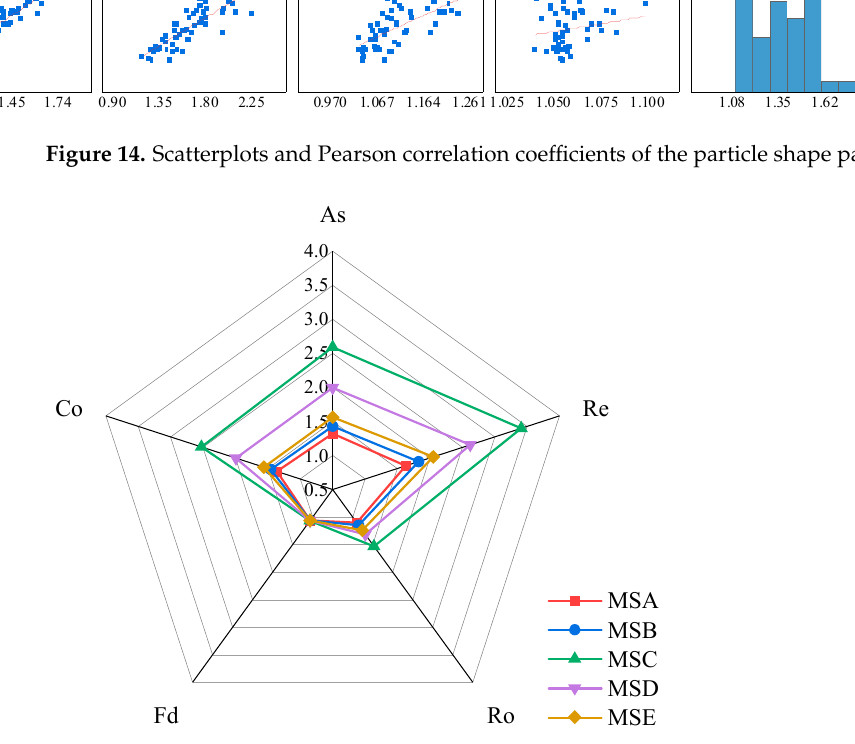
Figure 15. Average values of different DIP shape parameters.